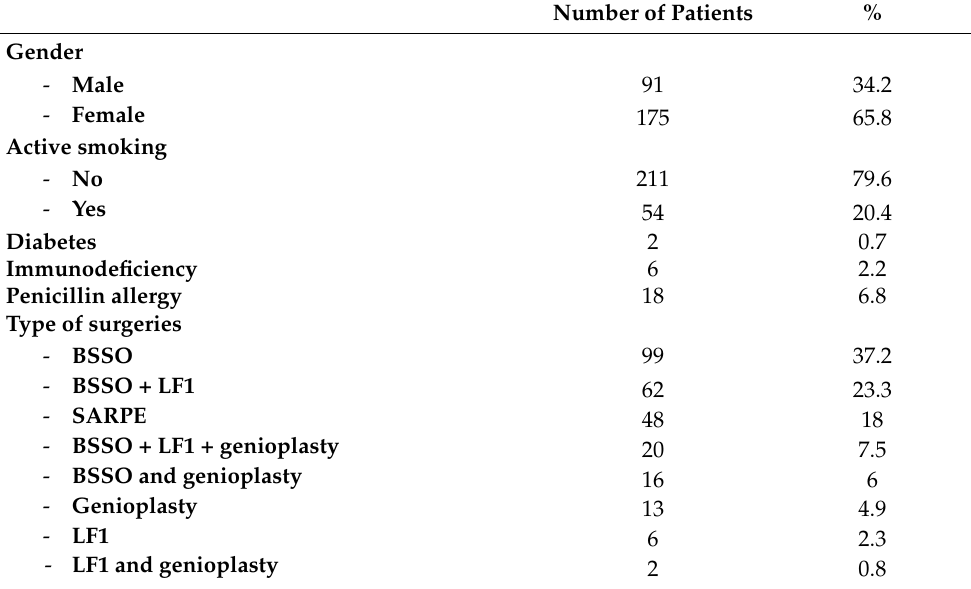
Table 1. Characteristics of the patients and type of